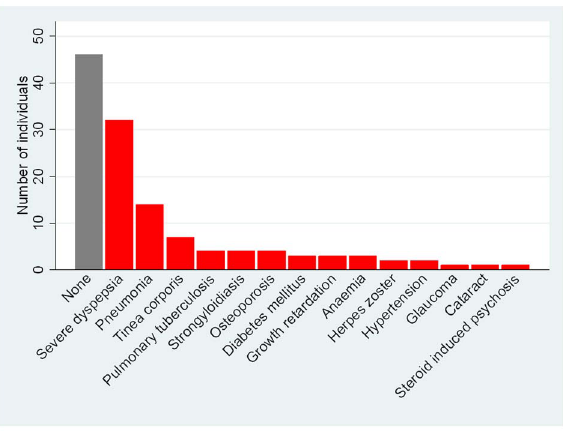
Figure 3. Co-morbidity associated with ENL.